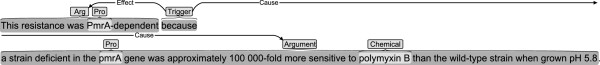
Explicit trigger reason/result. Example of Cause–Reason/Result annotation with an explicit trigger.